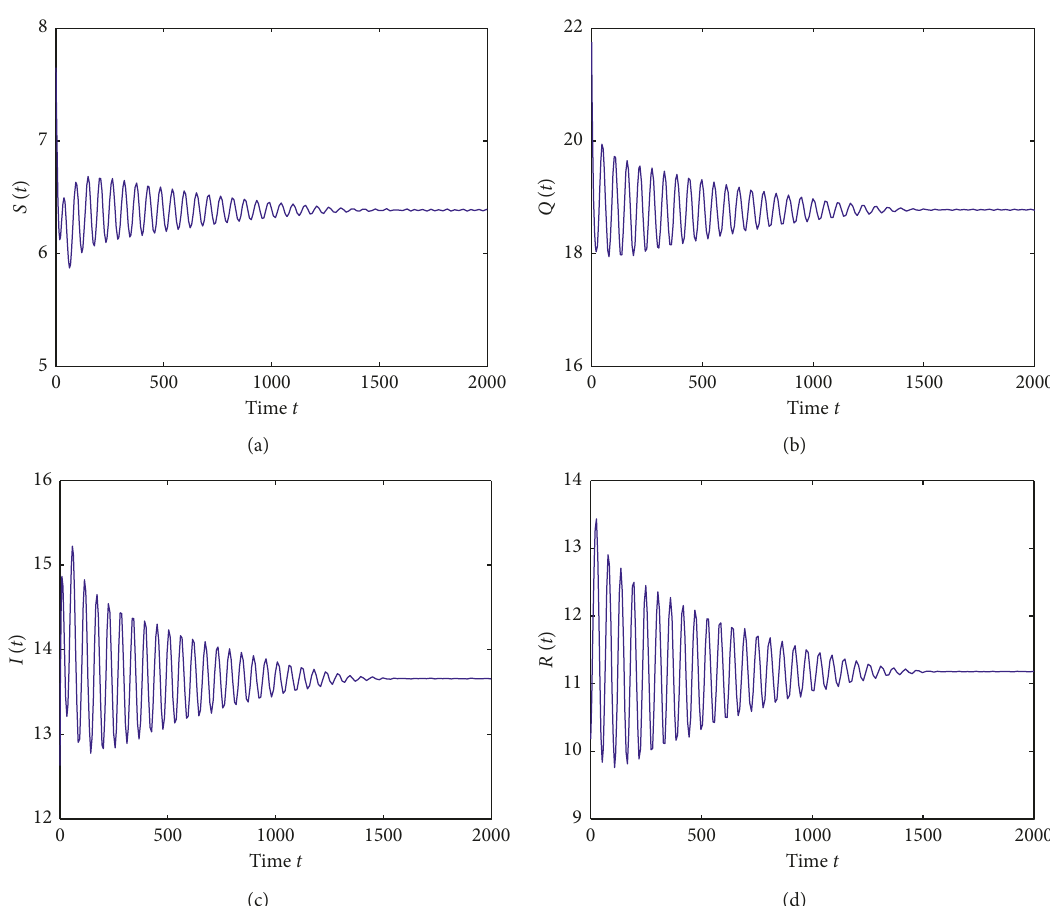
Figure 4: Waveform plots of system (65) with τ